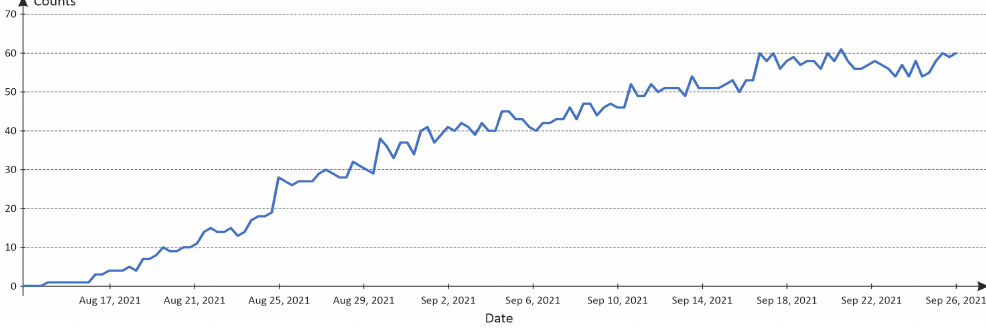
Figure 13. Grapevine moth males tally plot during the entire monitoring